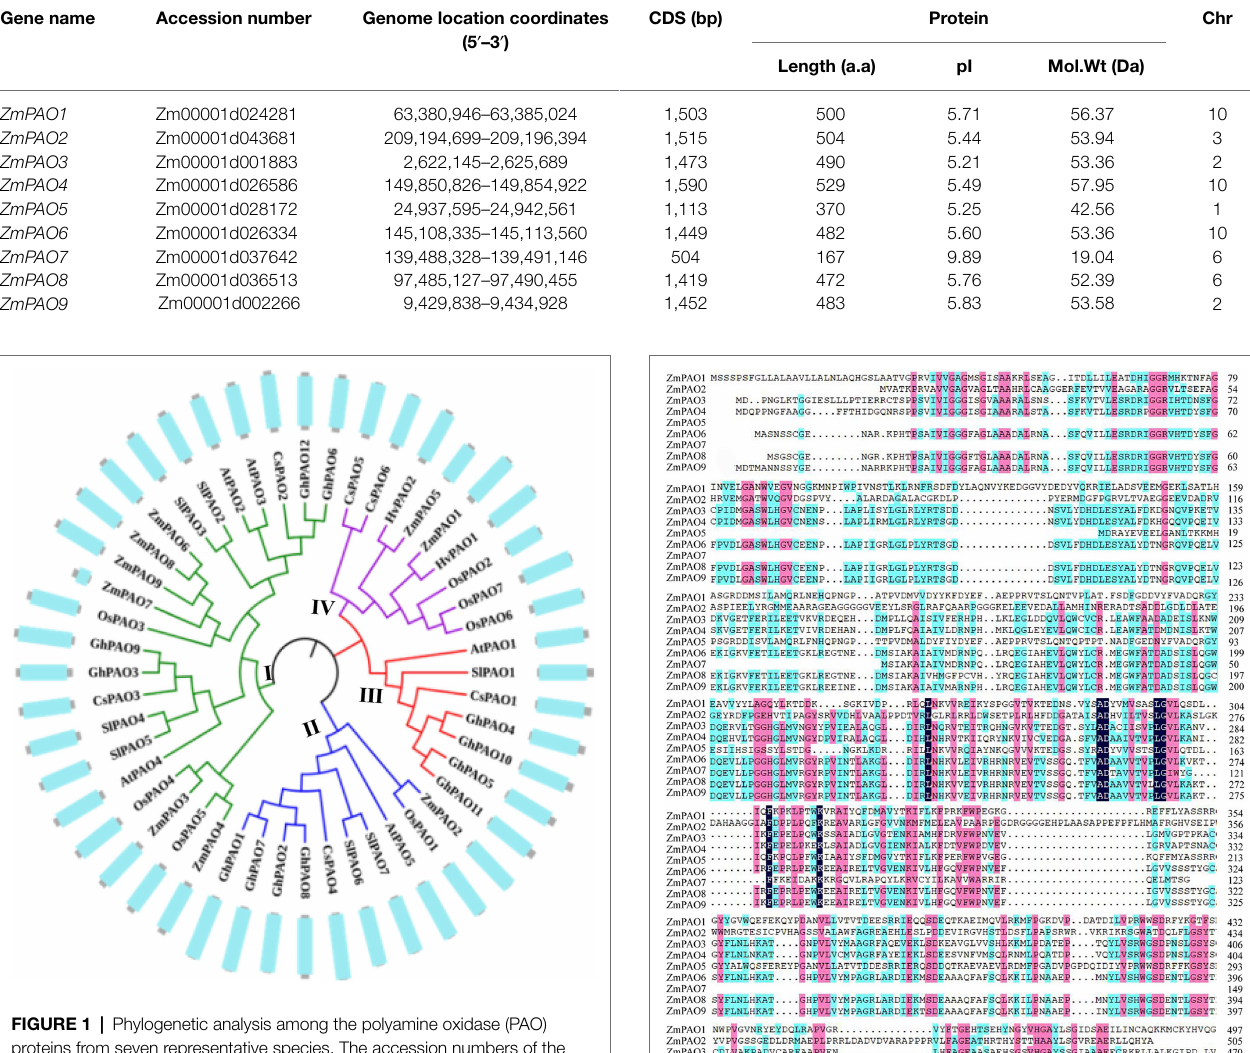
TABLE 1 | Basic information on PAO gene family in